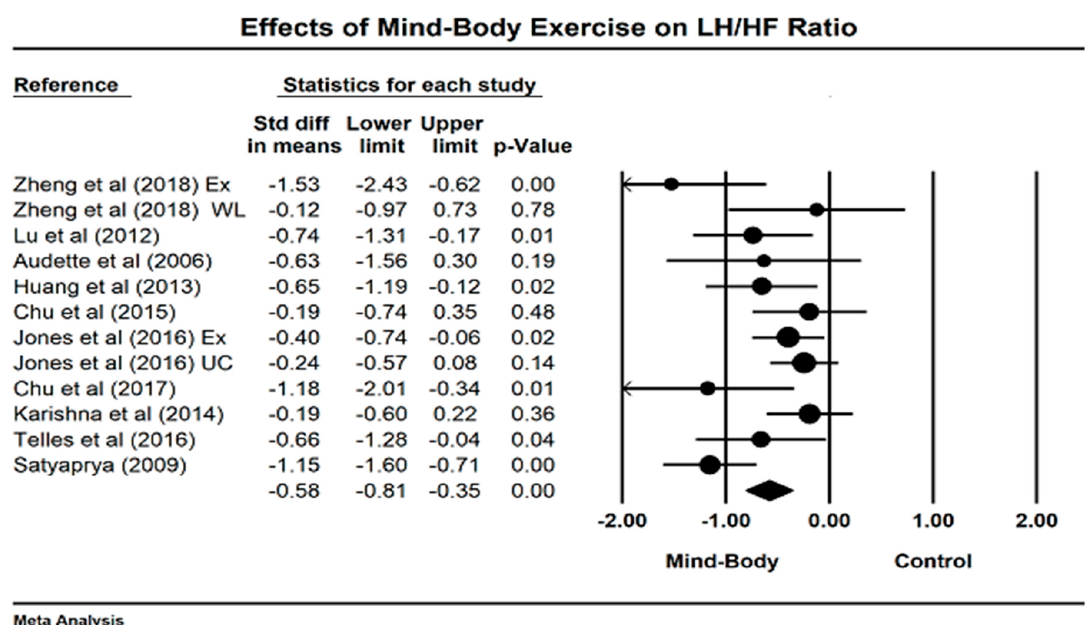
Figure 6. Funnel plot of publication bias for low-frequent to high-frequency ratio.